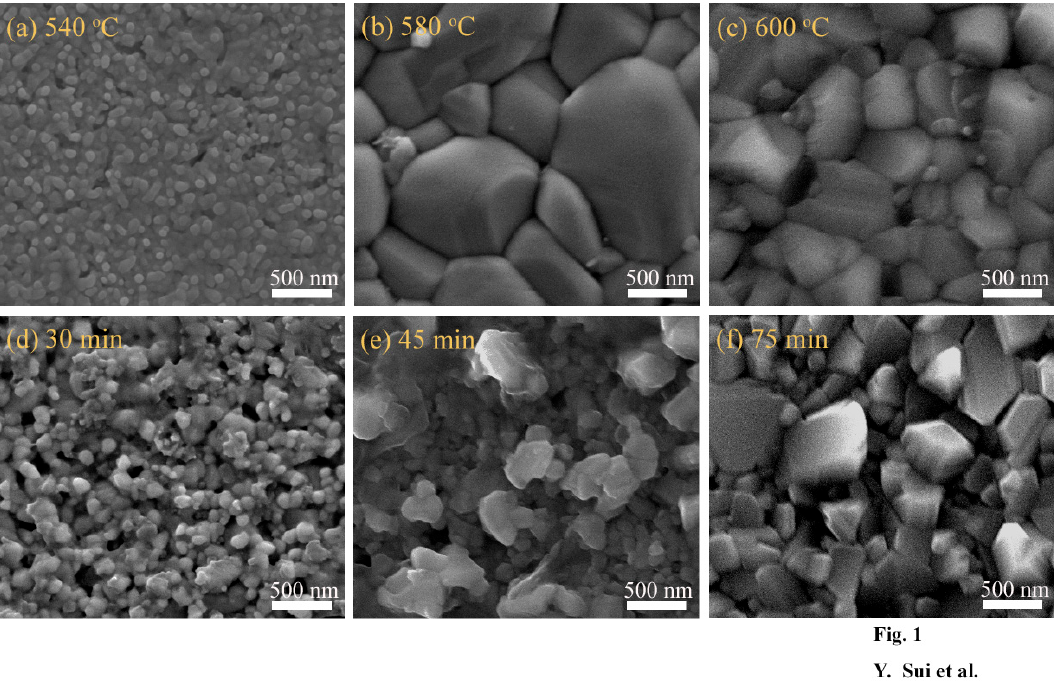
Figure 1. Scanning electron microscopy (SEM) images of Cu 2 Mg x Zn 1 − x SnS 4 (0 ≤ x ≤ 0.6) thin films annealed at a different annealing condition: ( a ) 540 °C, 60 min; ( b ) 580 °C, 60 min; ( c ) 600 °C, 60 min; ( d ) 580 °C, 30 min; ( e ) 580 °C, 45 min and ( f ) 580 °C, 75 min.